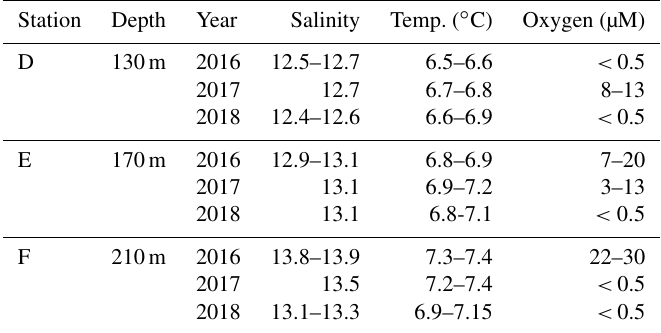
Table A1. Description of stations. Bottom water salinity, temperature, and oxygen concentration as measured by the benthic chamber lander or CTD. Limit of detection for oxygen was